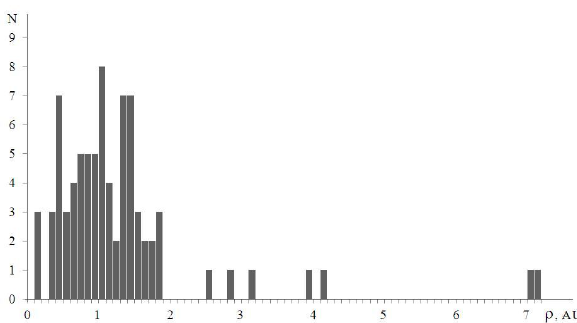
Figure 4. The dependence of the number of comets N with an anomalous tail on the geocentric distance ρ .